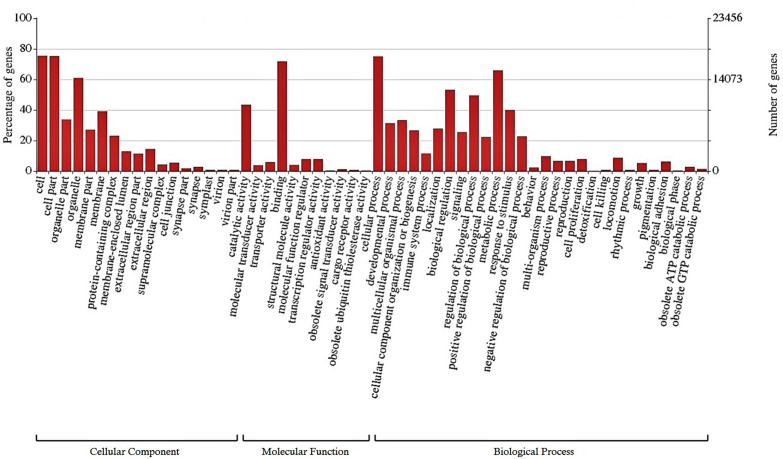
Functional classification of the liver transcriptome of pacu (P. mesopotamicus) exposed to A. hydrophila infection. The transcripts were classified in the x-axis, according to Gene Ontology (GO) categories at level 2: cellular component, molecular function and biological process (E-value < 1e-3). The primary y-axis represents the percentage of genes classified in each subcategory, whereas the secondary y-axis represents the number of classified genes.